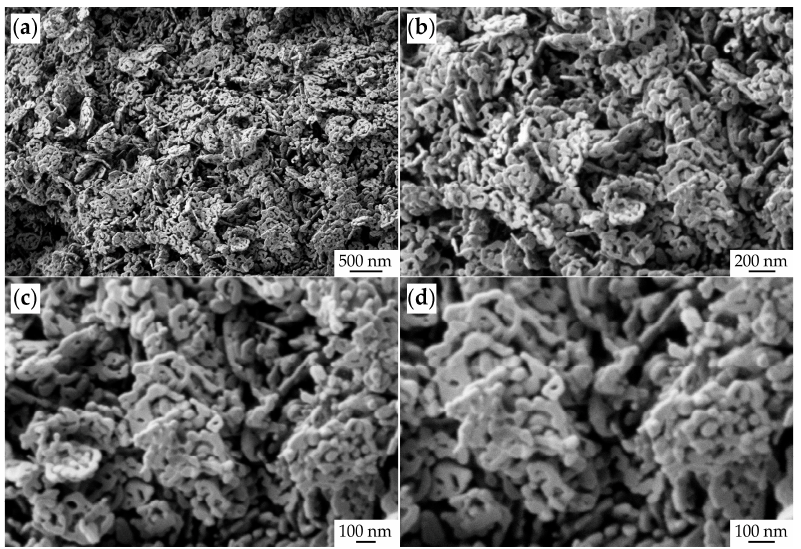
Figure 4. Microstructure of the obtained Co 3 O 4 nanopowder (according to SEM data; ×50 k ( a ), ×100 k ( b ), ×150 k ( c ), ×200 k ( d )).